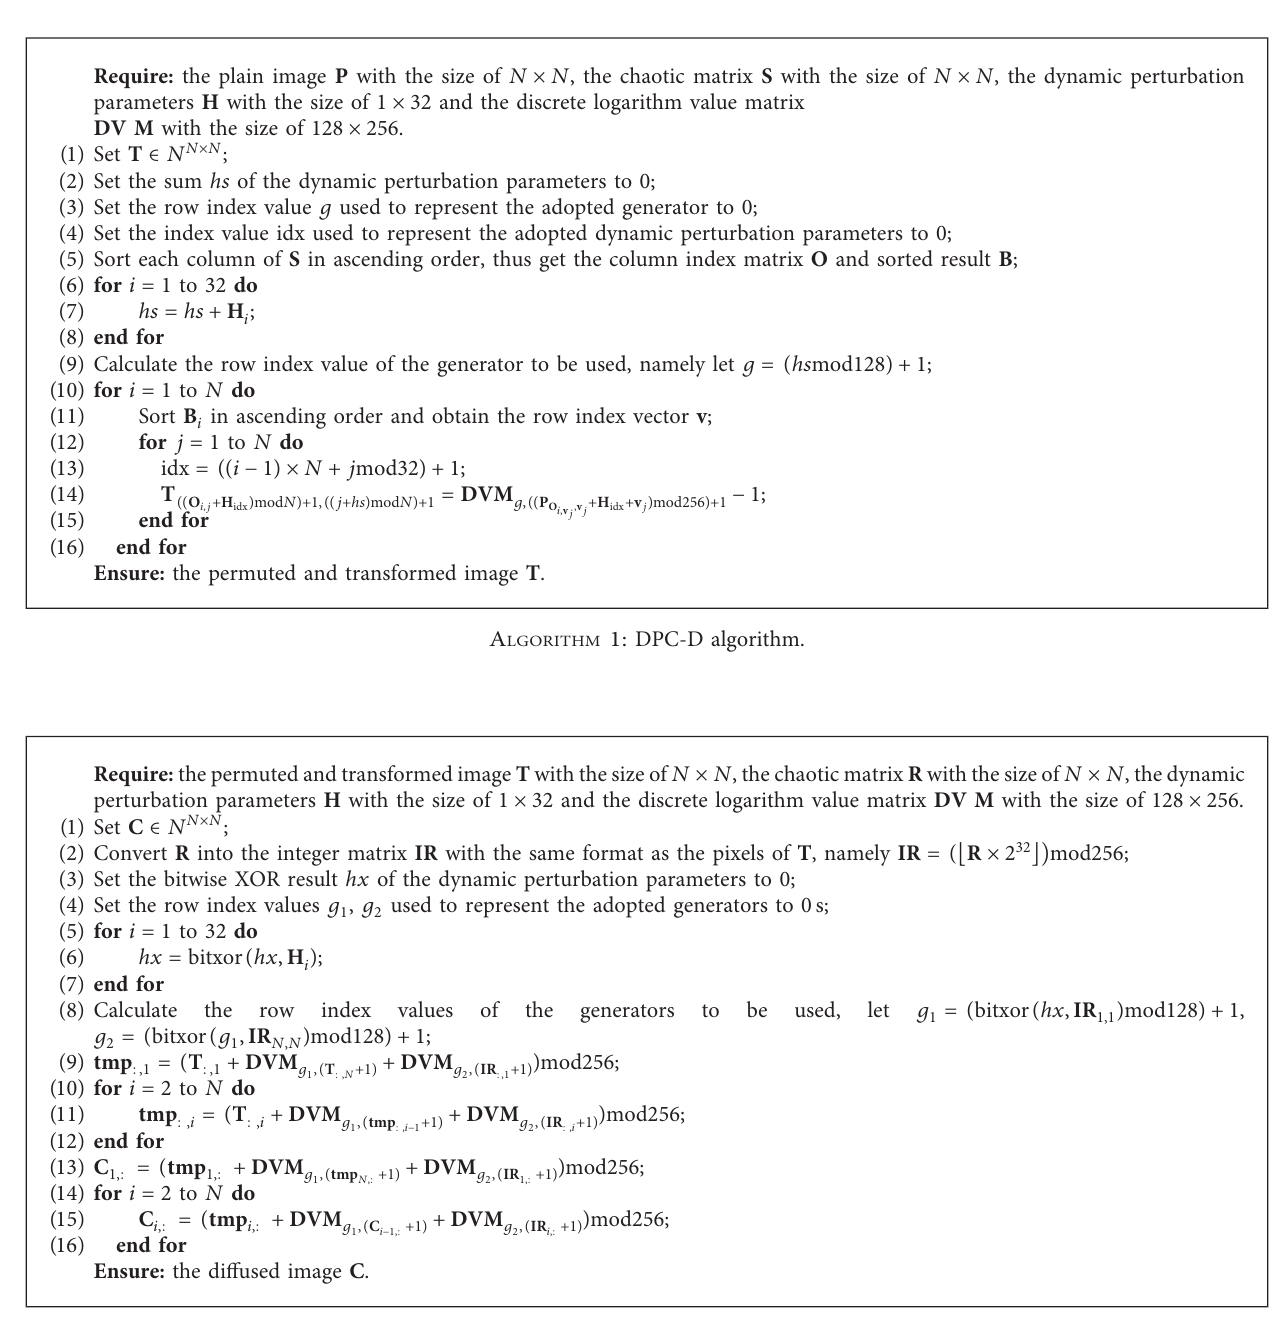
A LGORITHM 2: DD-D